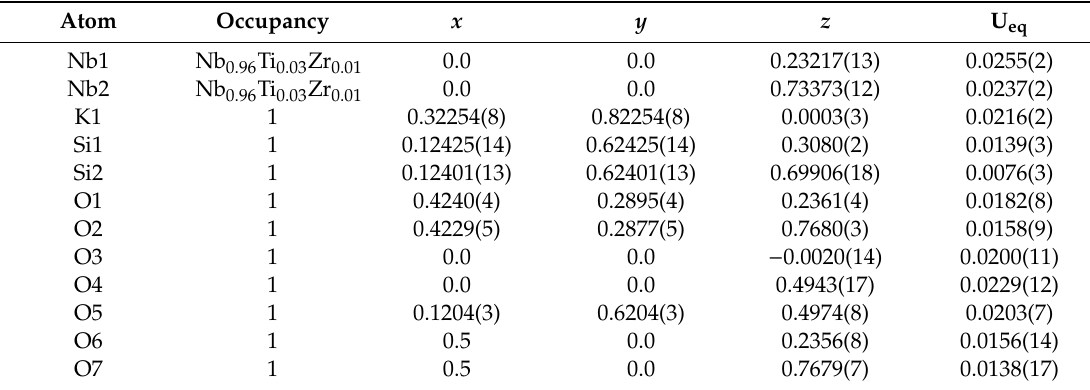
Table 7. Atom coordinates, U eq (Å 2 ) values, and occupancies for